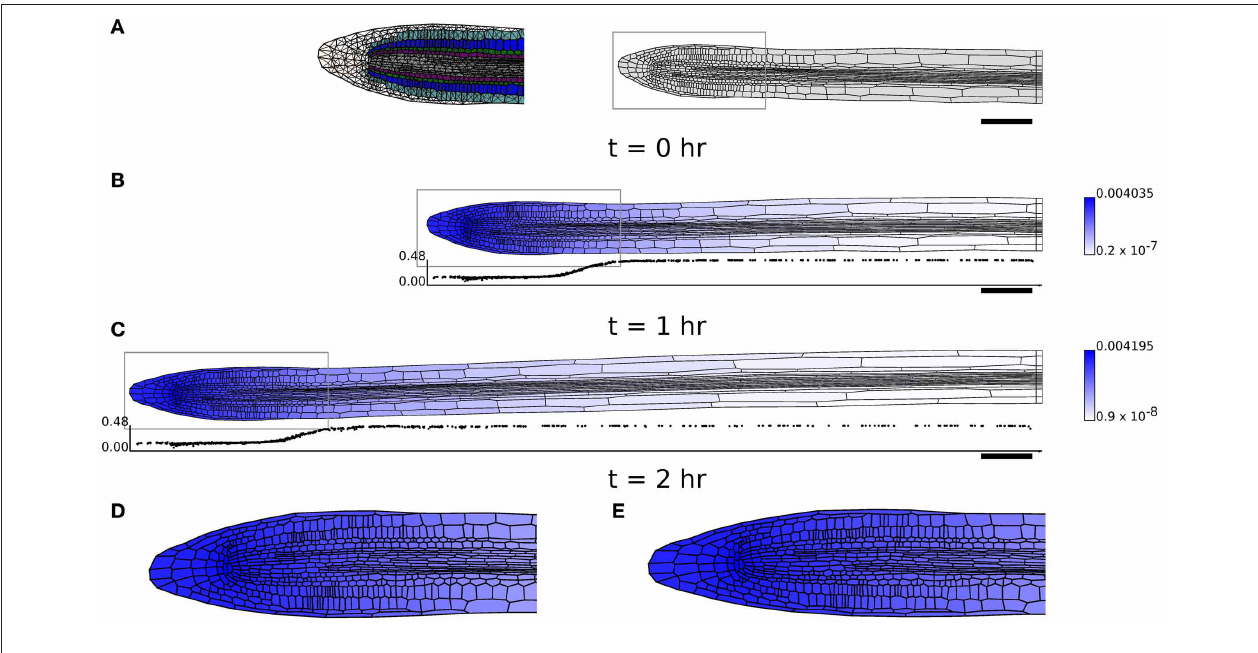
in gray in (B,C) in more detail. Triangulation of geometry has 8937 elements (see (A) ). Simulation parameters are as in Table 1 , except